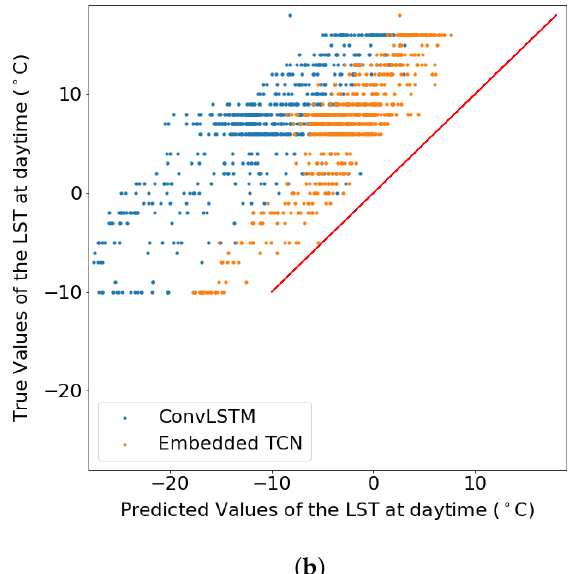
Figure 8. The true values of the daytime land surface temperature in June 2020 as a function of the predicted values when the dataset consisted of 210 images of 28 × 28 obtained from a region in Sweden with resolution (per pixel) ( a ) 1 km, ( b ) 5 km. ( a ) LST prediction for 1 km spatial resolution. ( b ) LST prediction for 5 km spatial resolution.